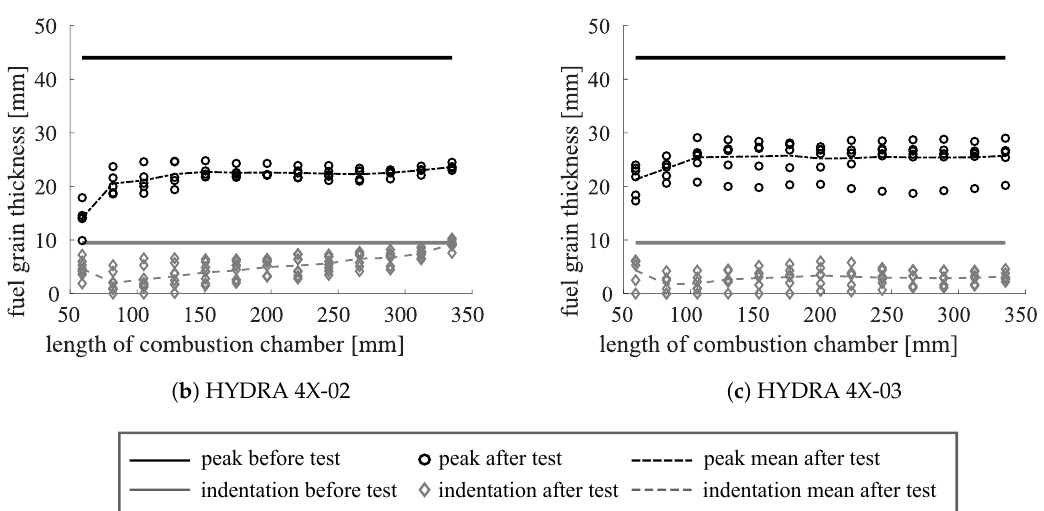
( a ) Comparison of fuel grain geometries v1 (left) used in H4X-01 and H4X-02 and v2 (middle) used in H4X-03 and H4X-04. Measurement points for geometric consumption are indicated in the respective geometries on the right.